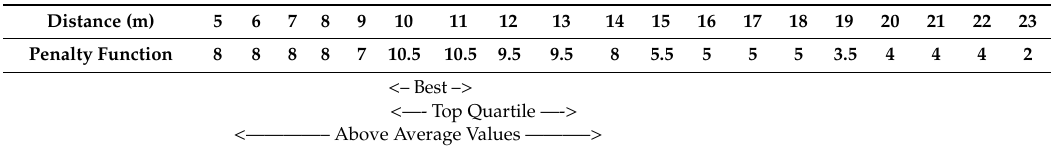
Table 11. Inverted penalty function algorithm